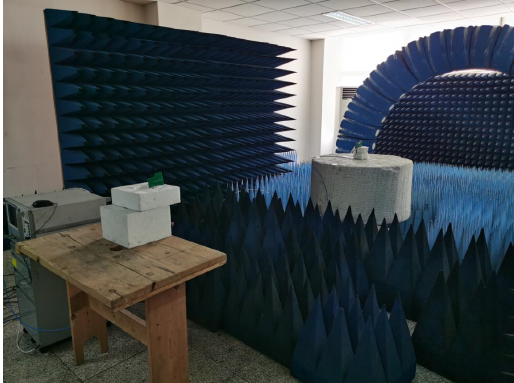
Figure 6. Testing environment with the Vivaldi antenna alone.